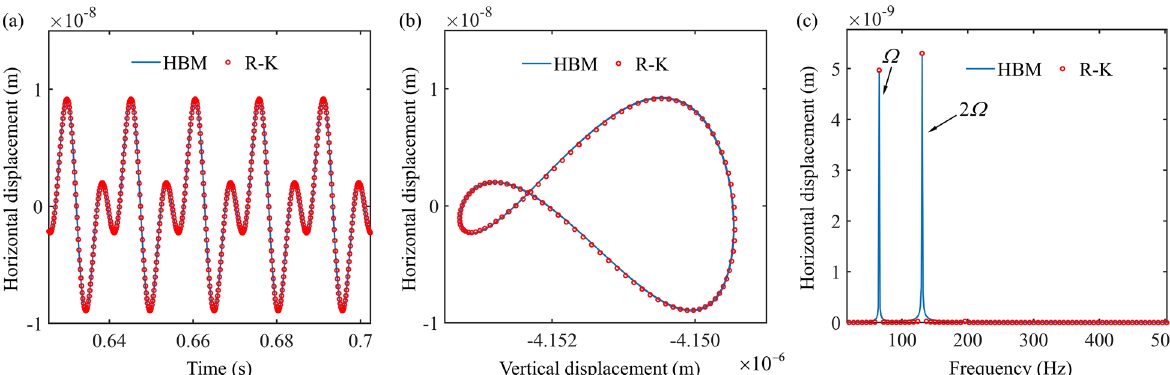
1 / 2 ω 1 at node 10: ( a ) Time 0.3, c p 10, and Ω 410 rad/s = = = ≈